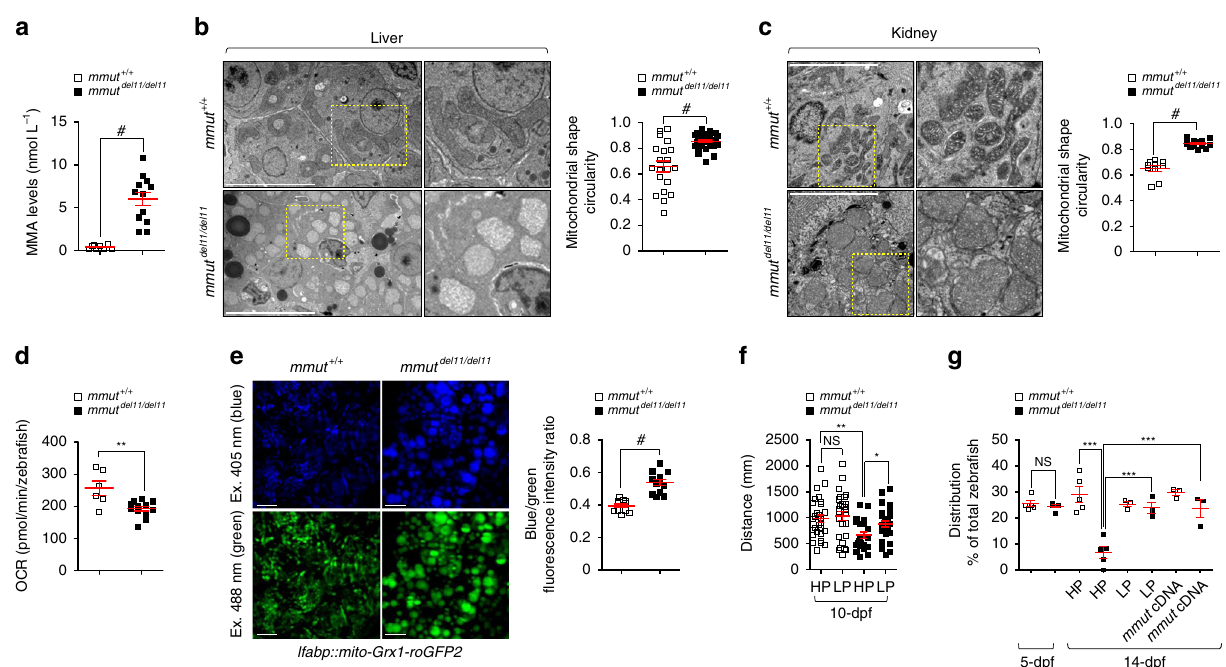
Fig. 3 Mitochondrial abnormalities and phenotypic changes in mmut- de fi cient zebra fi sh. a Quanti fi cation of MMA levels by LC-MS/MS; n = 8 mmut + / + and n = 12 mmut del11/del11 zebra fi sh larvae. b , c Representative images and quanti fi cation of the mitochondrial shape (expressed as circularity) in ( b ) livers and in ( c ) kidneys of 10-dpf mmut zebra fi sh ( n ≥ 9 and n ≥ 10 randomly selected and non-overlapping fi elds of views for zebra fi sh livers and kidneys, respectively). The whole- fi eld images are pooled from three distinct zebra fi sh kidneys and livers, respectively. Dotted yellow squares contain images at higher magni fi cation. d Oxygen consumption rate (OCR) and individual parameters for basal respiration in 10-dpf- mmut zebra fi sh, n = 6 mmut + / + and 12 mmut del11/del11 zebra fi sh larvae. e Zebra fi sh expressing mito-Grx1-roGFP2 in the liver were outcrossed with mmut + /del11 zebra fi sh. Representative images and quanti fi cation of the ratio between 405 (blue) and 488 (green) fl uorescence intensities, with each point representing the average blue/green fl uorescence intensity ratio in a zebra fi sh liver; n = 11 mmut + / + and n = 12 mmut del11/del11 zebra fi sh larvae. f Tracking analyses of motor behaviour in 10-dpf - mmut zebra fi sh fed with a high- or low-protein diet (HP or LP, respectively). Quanti fi cation of the distance, with each point representing the average distance covered by an individual zebra fi sh; n = 28 HP-fed mmut + / + , n = 26 LP-fed mmut + / + , n = 23 HP-fed mmut del11/del11 and n = 27 LP-fed mmut del11/del11 zebra fi sh larvae. g Distribution of mmut zebra fi sh (expressed as the percentage of the total zebra fi sh larvae) in 5-dpf or in 14-dpf zebra fi sh fed with either HP or LP diet or in mmut zebra fi sh stably expressing mmut in the liver; n ≥ 3 biologically independent experiments, with each containing ~100 mmut zebra fi sh larvae. Plots represent mean ±SEM. Two-tailed Student ’ s t -test, * P < 0.05, ** P < 0.01 and # P < 0.0001 relative to mmut + / + or HP- mmut del11/del11 in a – f . One- way ANOVA followed by Bonferroni ’ s post hoc test, *** P < 0.001 relative to mmut + / + or 14-dpf-HP-fed mmut + / + or to 14-dpf-HP-fed mmut del11/del11 zebra fi sh larvae in g . Scale bars are 5 μ m in b and c , and 100 μ m in e . NS non-signi fi cant. Source data are provided as a Source Data fi